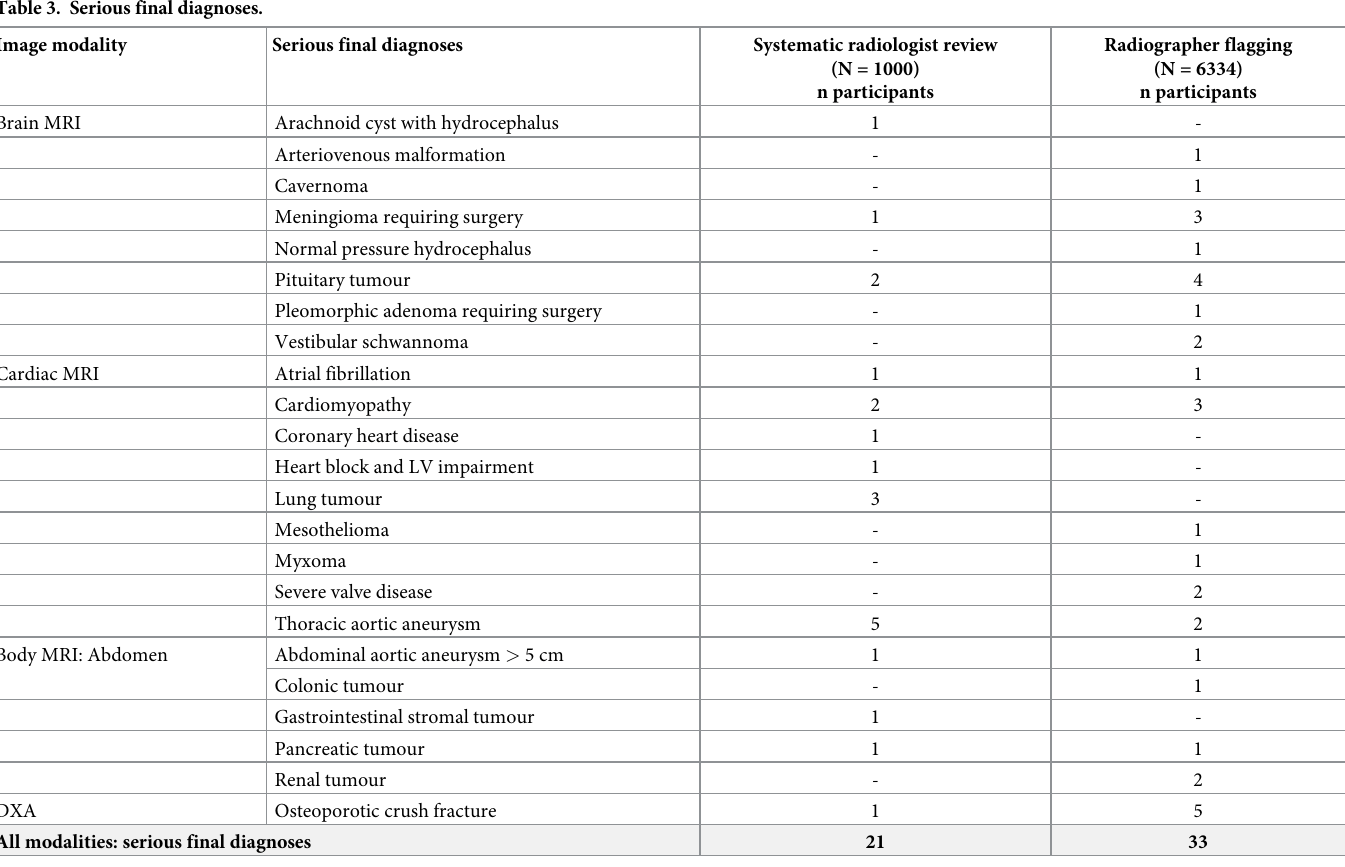
Table 3. Serious final